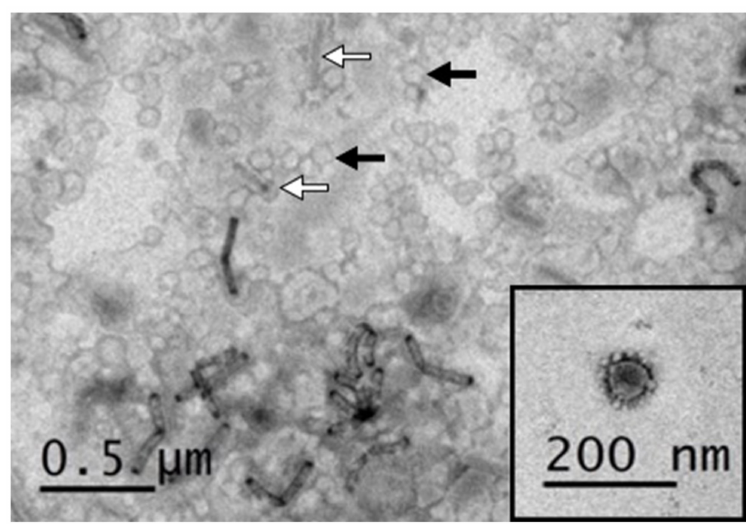
Figure 5. PEDV-like particles released in the culture supernatant of 1 MOI SME-Bac-infected Sf21 cells after 5-day infection. The electron micrograph demonstrates the morphology of VLPs (black arrows and inset figure) and baculovirus virions (white arrows).